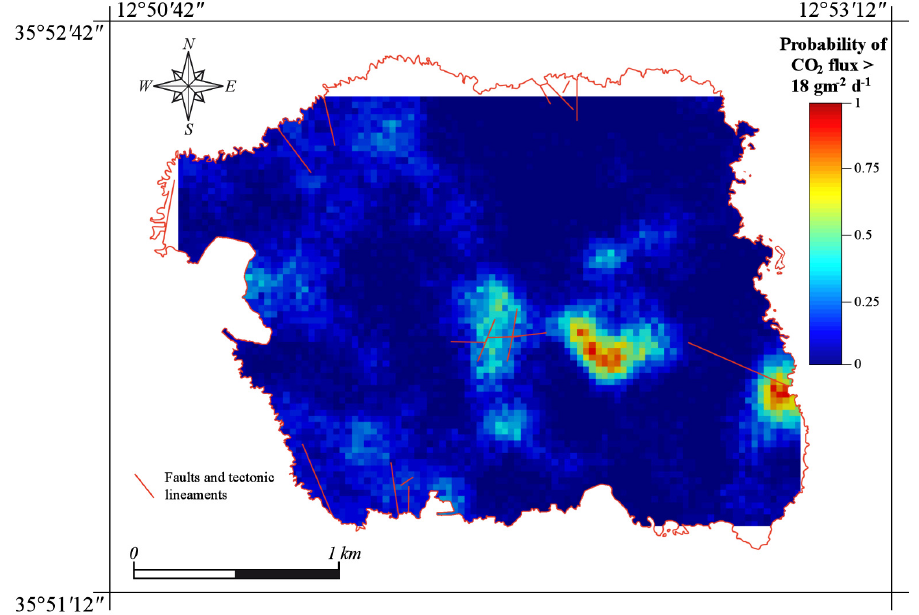
flux. The main 2